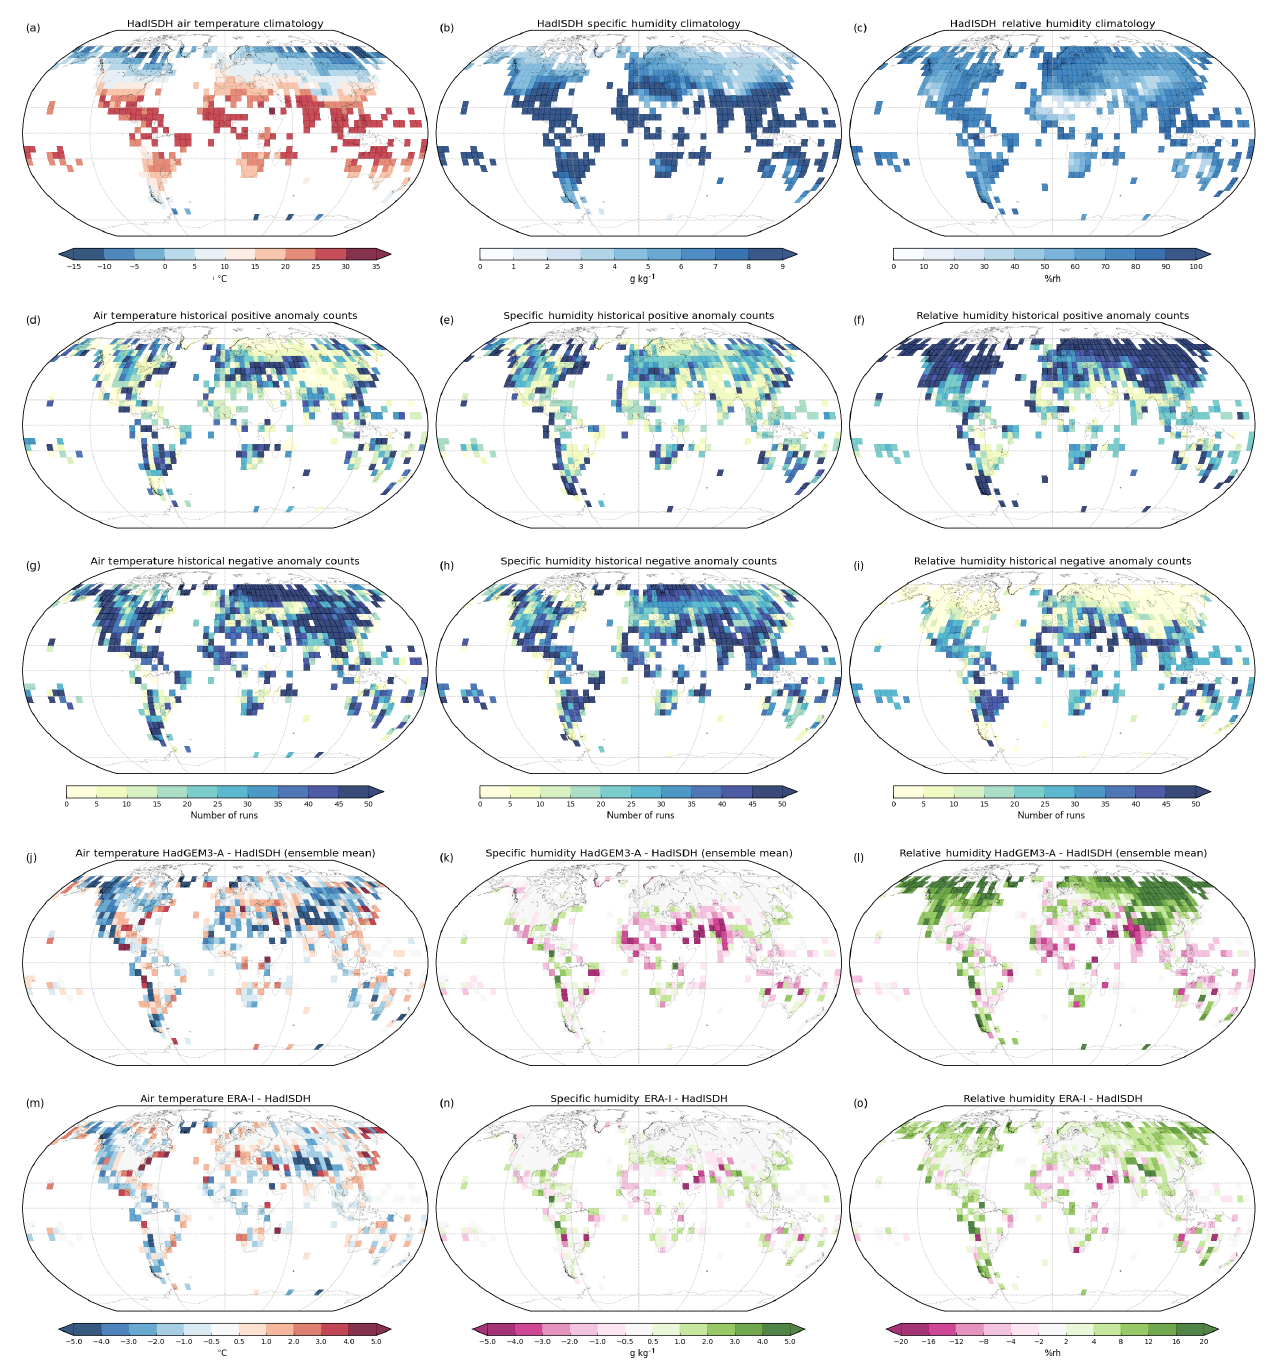
Figure 5. Climatological differences between models and observations on the grid box scale. (a, b, c) The climatology of HadISD for air temperature, specific humidity and relative humidity respectively. Frequency of historically forced CMIP5 models with (d, e, f) posi- tive bias (warmer, moister or more humid) or (g, h, i) negative bias (cooler, drier or more arid) relative to HadISDH for air temperature, specific humidity and relative humidity respectively. For (d) to (i) shading scales with the multi-model mean difference of models minus HadISDH. (j, k, l) Difference (model minus observation) between HadGEM3-A and HadISDH for air temperature, specific humidity and relative humidity respectively. (m, n, o) Difference (reanalysis minus observation) between ERA-Interim and HadISDH for air temperature, specific humidity and relative humidity respectively. All climatologies have been calculated over the 1975 to 2005 period using spatio- temporal coverage identical to HadISDH, except for ERA-Interim, which starts in